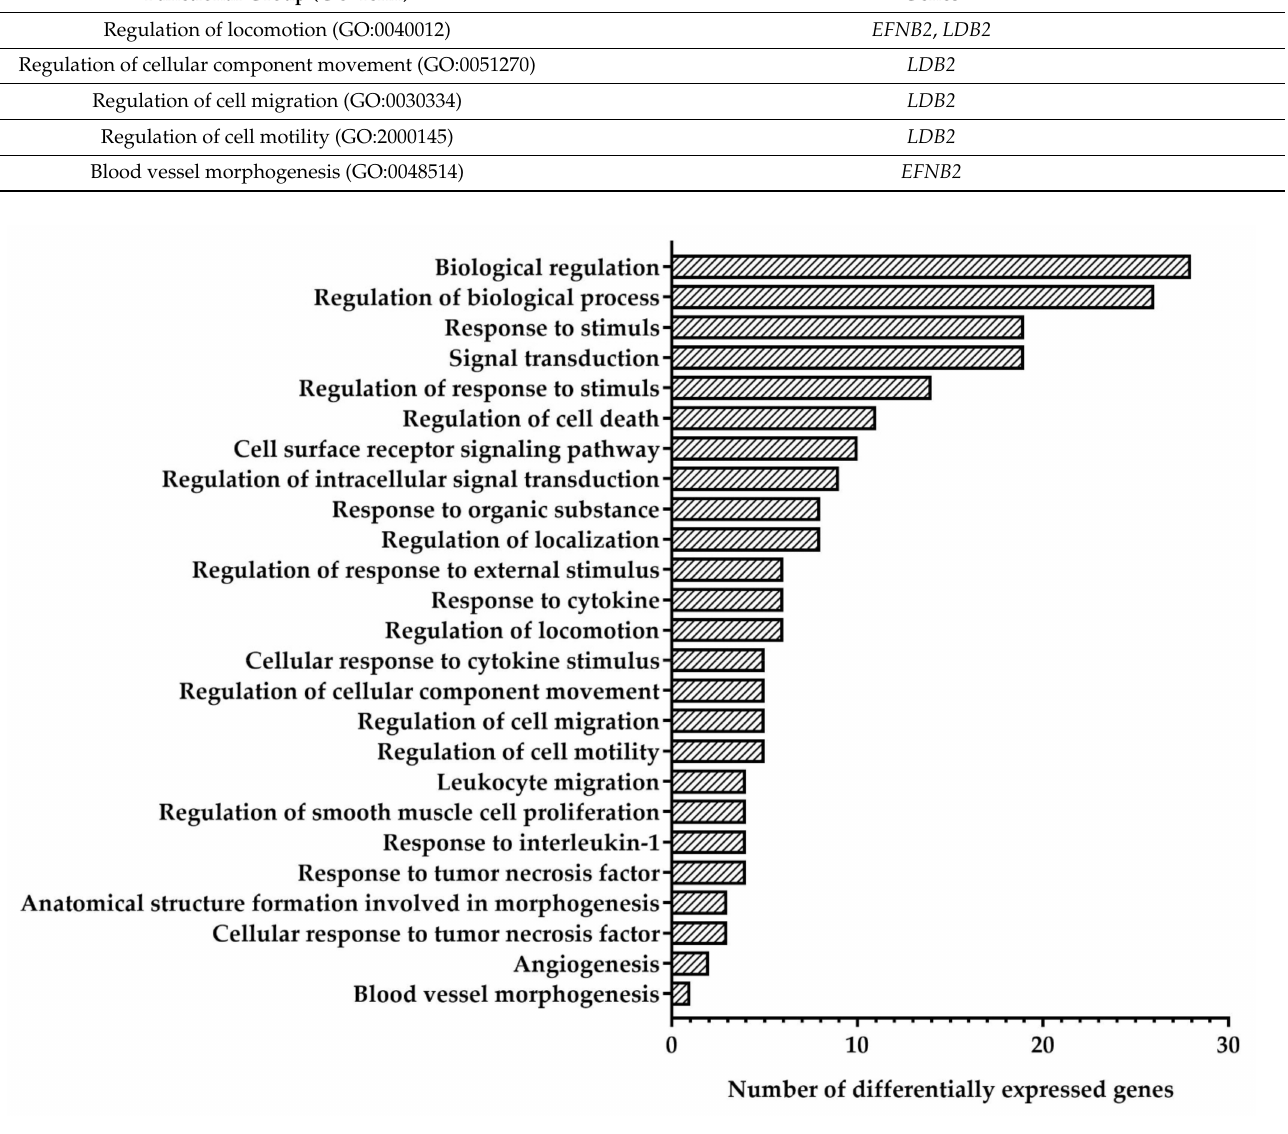
Figure 2. Quantity of differentially expressed genes (DEGs) identified in Human Coronary Artery Endothelial Cells (HCAEC) exposed to mitomycin C (MMC) in comparison with the non-exposed control in functional groups of biological processes according to Gene Ontology enrichment